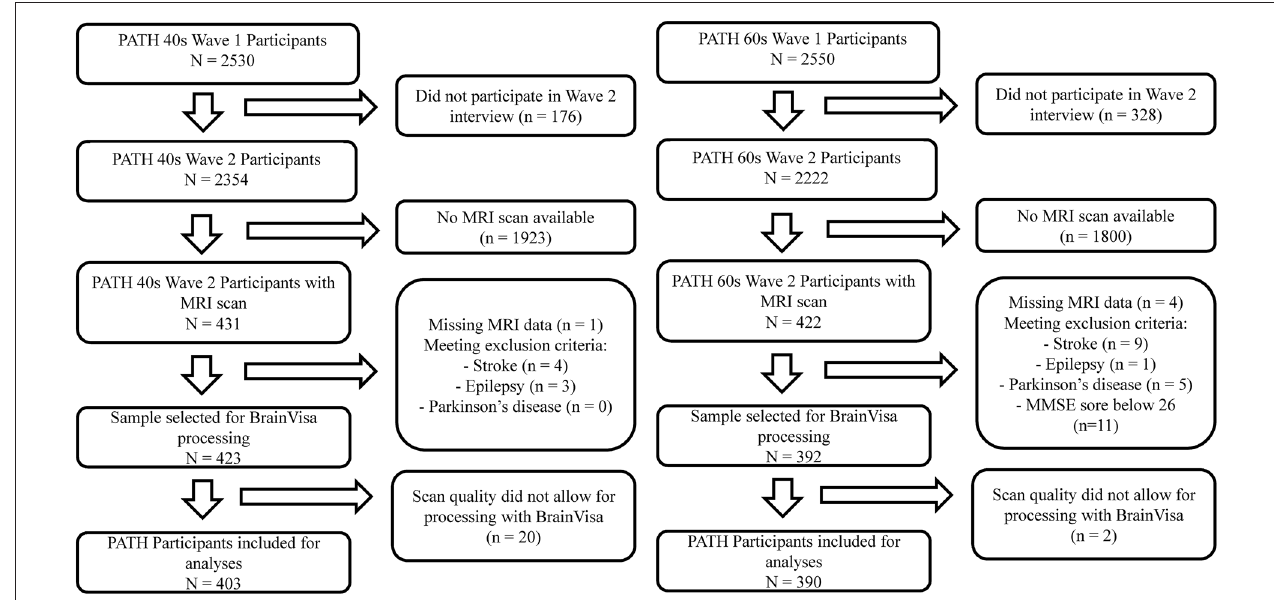
FIGURE 1 | Sample inclusion (left: 40+ cohort; right: 60+